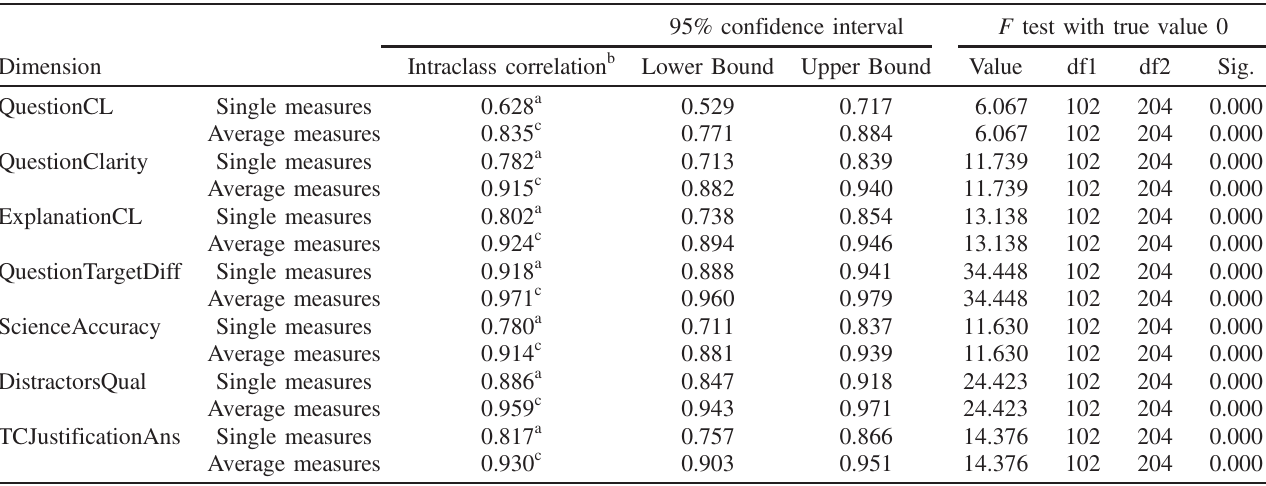
TABLE VII. Intraclass correlation